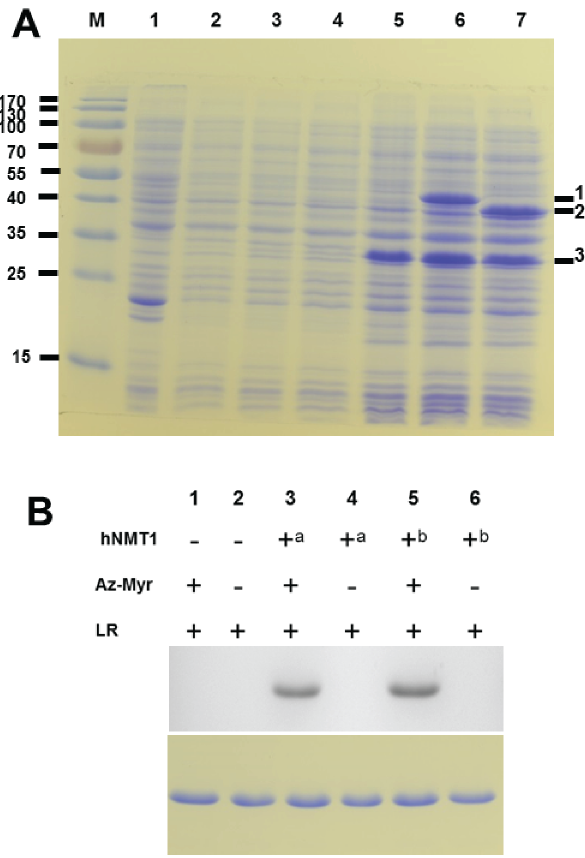
Fig 2. Analysis of N -myristoyltransferase activity in E . coli cells by complementation assay. A , SDS-PAGE analysis of Nef and NMT expression. The plasmid constructs encoding either Nef alone or with NMT transformed in Rosetta 2(DE3) cells were analyzed for expression, 8 hours after IPTG induction. Lane “ M ” corresponds to protein molecular weight marker, lane “ 1 ” control lysate from Rosetta 2(DE3) cells, lanes “ 2 – 4 ” and “ 5 – 7 ” pre and post-induction samples transformed with plasmids pETDuet-1 Δ 6His_Nef, pETDuet- 1 Δ 6His_hNMT_Nef and pETDuet-1 Δ 6His_ Δ 28-hNMT_Nef respectively. The proteins hNMT1s, Δ 28-hNMT1s and Nef are marked 1, 2 and 3 . B , Detection of N -myristoyltransferase activity in the E . coli complementation assay by metabolic labeling with bio-orthogonal myristic acid analogue. Myristoylation of Nef was evaluated by labeling with Az – Myr followed by ‘ click-chemistry ’ detection with Alexa Fluor 488-labelled DIBO alkyne as described in “ Materials and methods ” . The in-gel fluorescence signals (top panel) from myristoylated Nef-His isolated from E . coli cells either not expressing NMT (lane 1 and 2), expressing hNMT1s (lane 3 and 4) or expressing Δ 28-hNMT1s, (lane 5 and 6) treated with labeling reagent (LR) (tagged with or without Az – Myr) as indicated. a and b correspond to hNMT1s and Δ 28-hNMT1s respectively. The input levels of Nef-His were determined by Coomassie blue staining of the SDS – PAGE gel run in parallel (lower